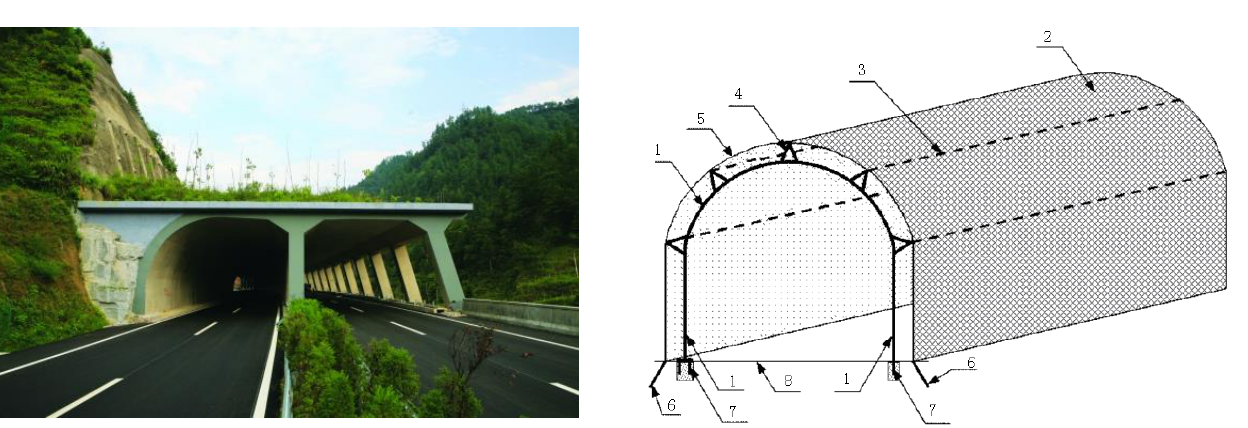
Fig. 1. Rock-shed on Chongqing to Hunan highway with reinforced concrete columns, foundation and a roof slab and the width of the road for single pass is 8.5m (Chongqing daily press photos)